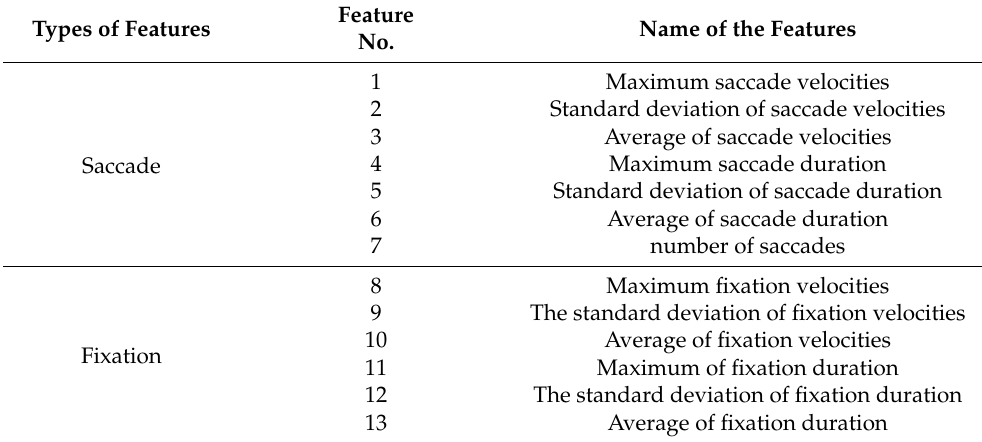
Table 1. List of saccade and fixation